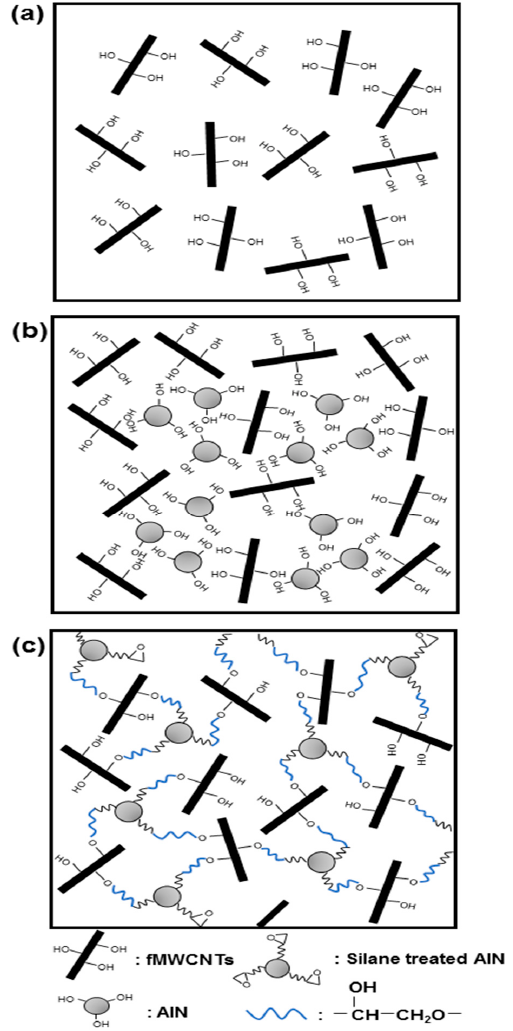
Figure 11. Schemes of the dispersion of the hybrid filler on the PPS matrix.